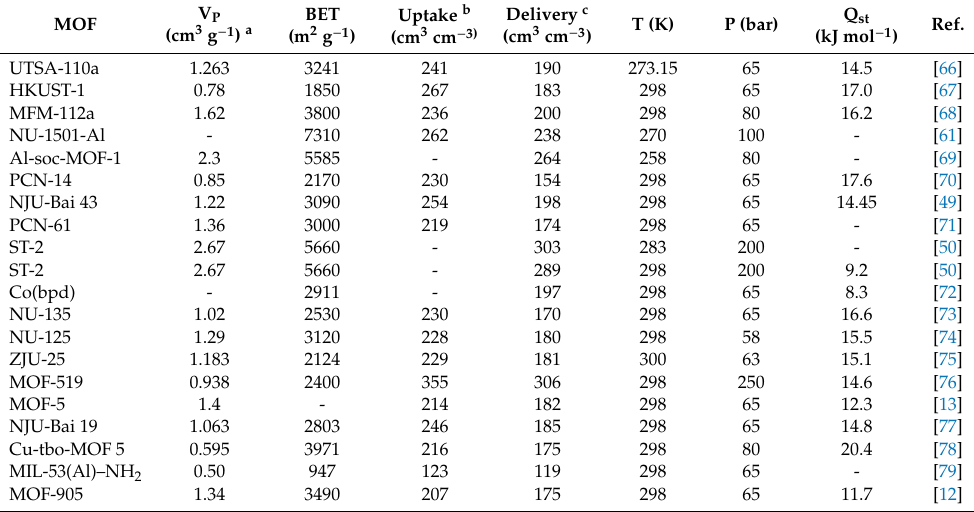
Table 1. Pore volume, methane uptake, and methane deliverable capacity of selected metal-organic frameworks (MOFs).